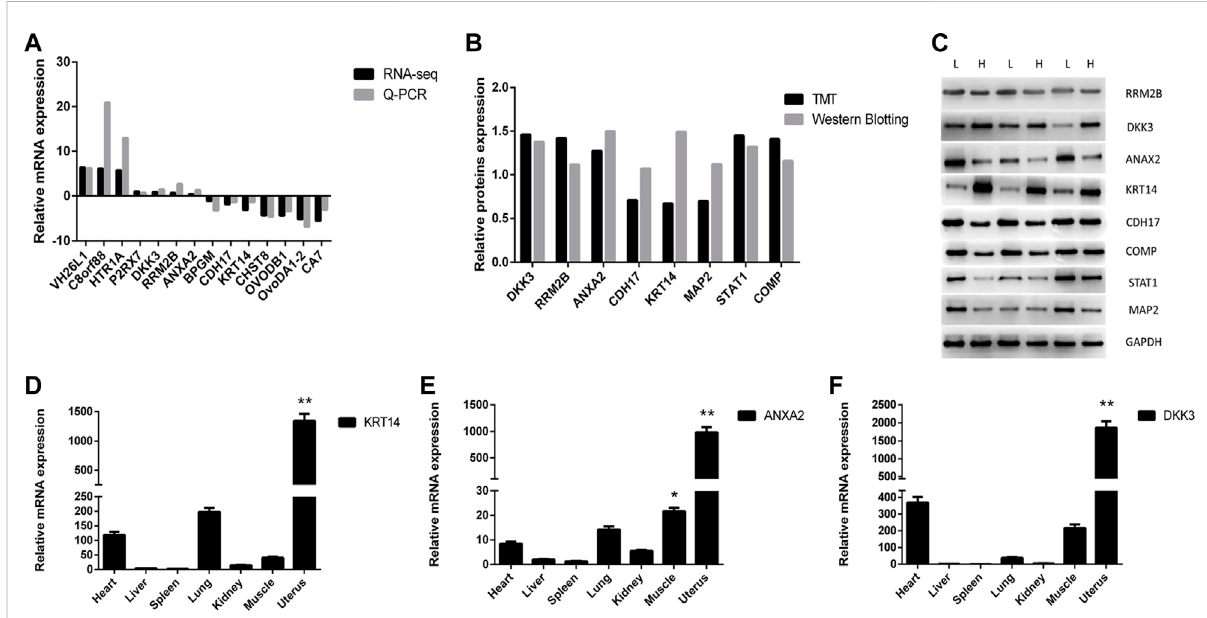
FIGURE 4 Identi fi cation and veri fi cation of differentially expressed gene and protein. (A) . Changes in DEG expression validated by qRT-PCR. Comparison results of the 14 mRNAs using the qRT-PCR and RNA-seq; (B) changes of DEP expression validatedby Western Blot. Comparison results of the eight proteins using the Western Blotting and TMT; (C) . Western Blot result of part DEPs; (D) relative expression of KRT14 in different tissues; (E) relative expression of ANXA2 in different tissues; (F) relative expression of DKK3 in different